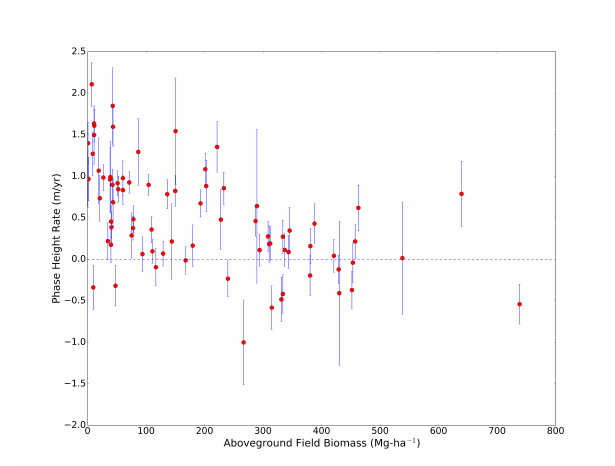
Figure 7. The phase-height rates estimated from (9) versus field AGB. Many of the points below 250 Mg-ha − 1 are above the dashed zero line by more than an error bar, suggesting higher phase rates at lower values of AGB.